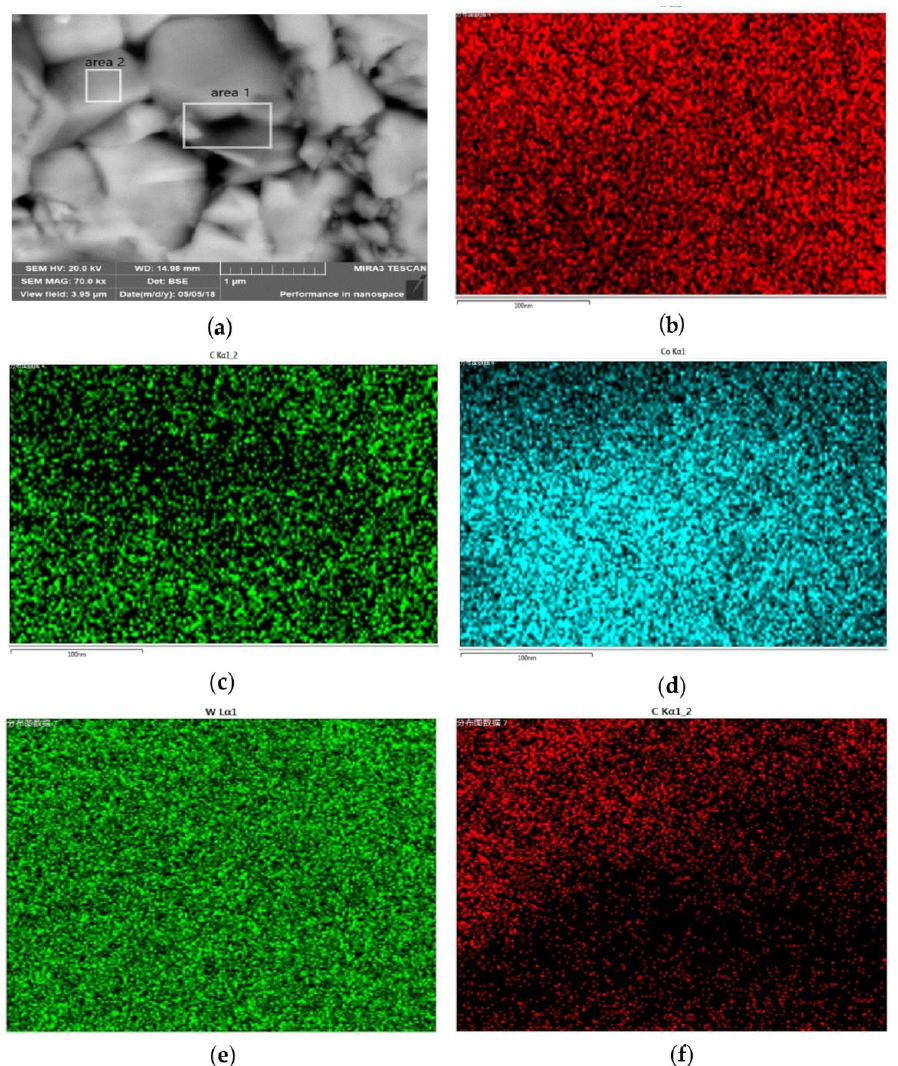
Figure 9. ( a ) Image of areas used for EDS analysis; ( b ) distribution of W content in area 1; ( c ) distribution of Co content in area 1; ( d ) distribution of C content in area 1; ( e ) distribution of W content in area 2; ( f ) distribution of C content in area